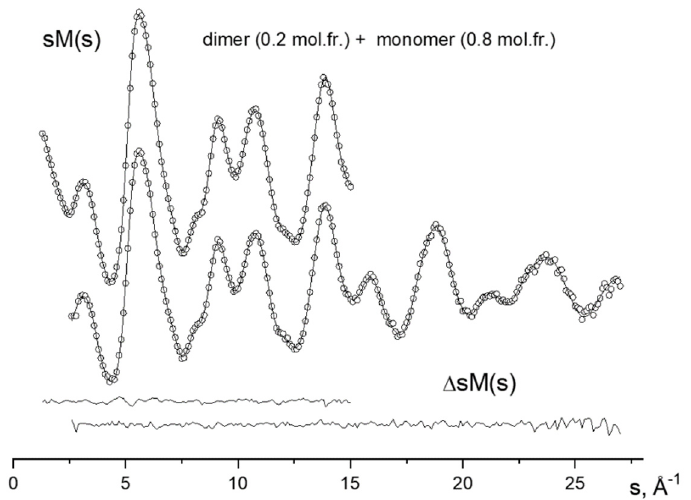
Figure 3. Experimental (points) and theoretical (lines) curves of the molecular scattering intensity sM(s) and their difference.